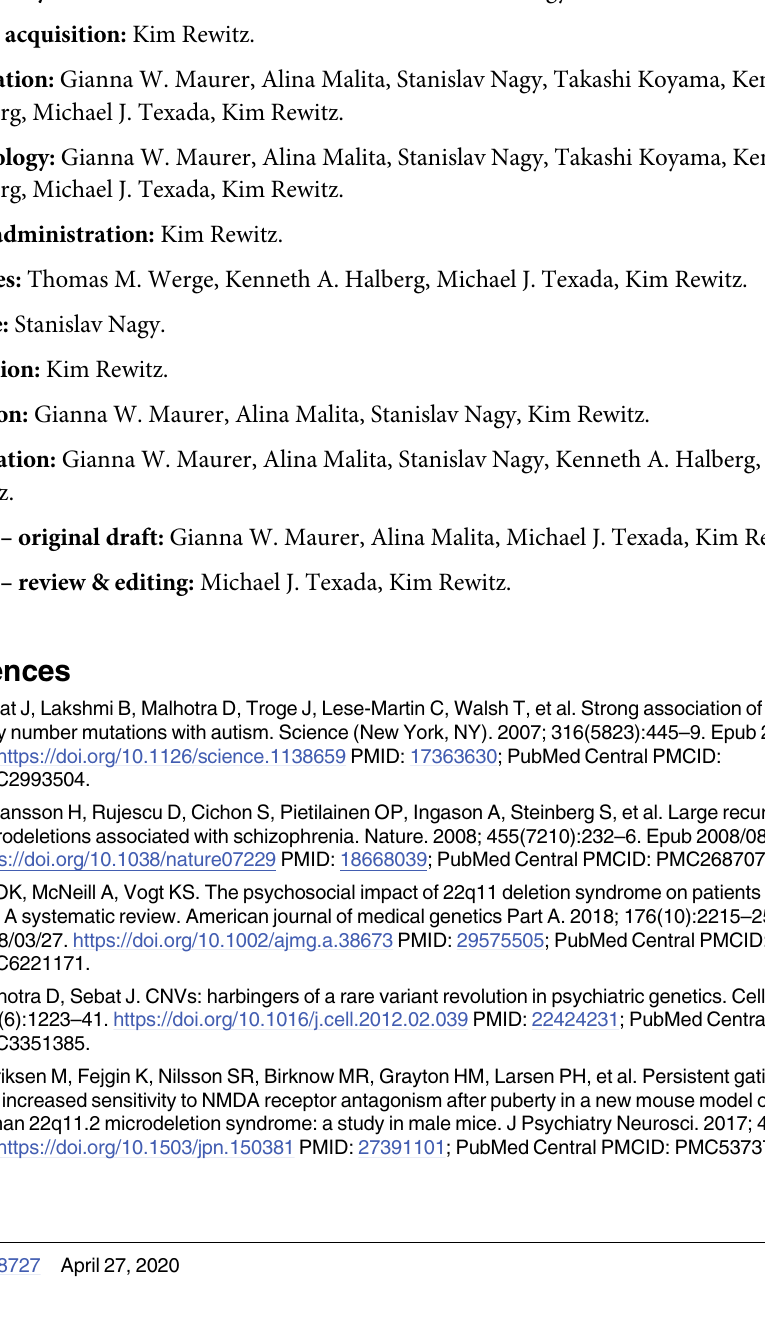
S1 Table. Transgenic UAS-RNAi fly lines targeting orthologs of 22q11.2-linked genes.